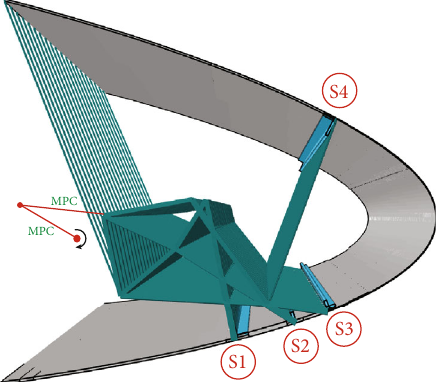
Figure 6: Complete fi nite element model of the droop nose.